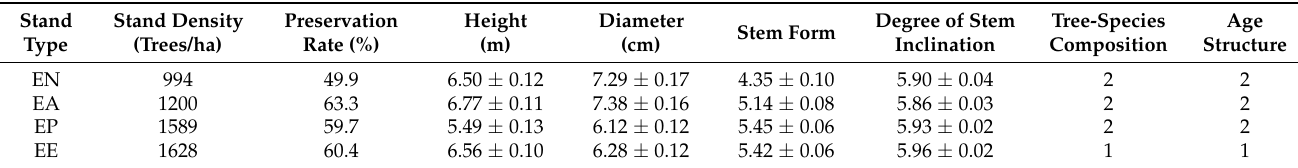
Table 8. Summary statistics of pure and mixed- Eucalyptus plantation.